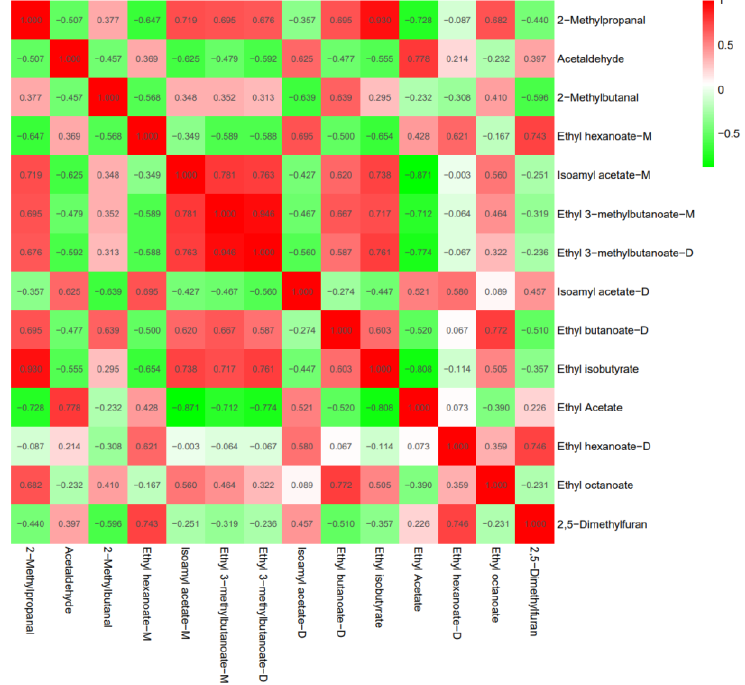
Figure 10. Analyses of the correlation between aroma compounds and OAV greater than 1 in nine grape wine varieties. grape wine